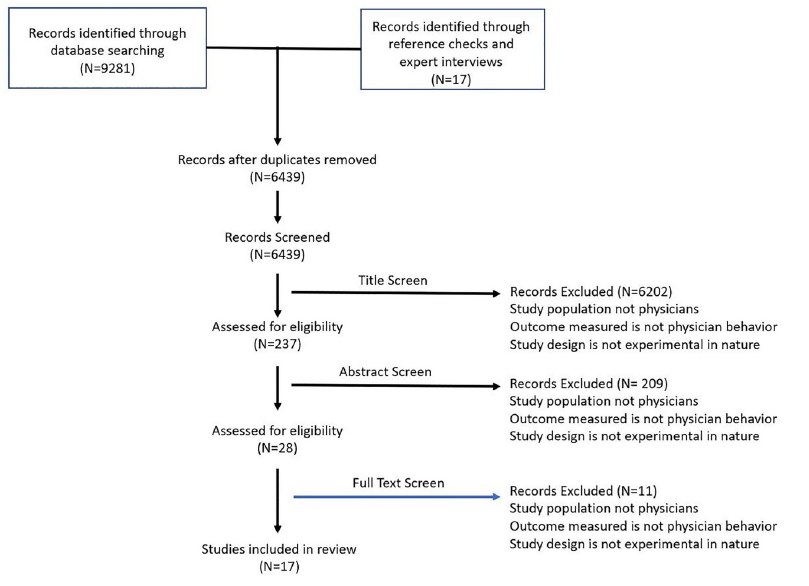
Fig 1. PRISMA diagram of included